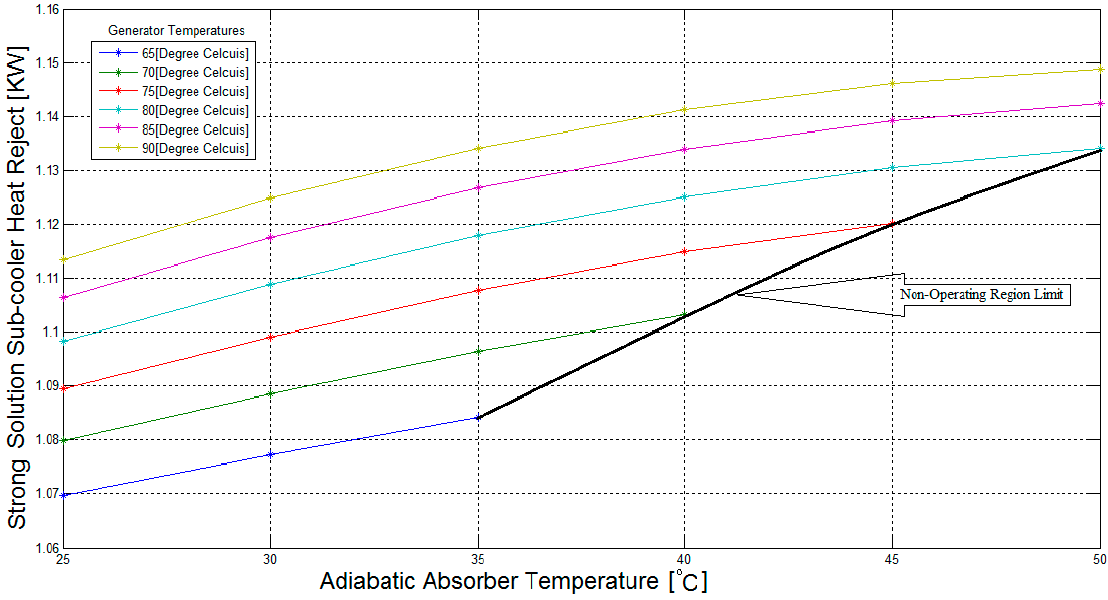
Figure 8. Graph showing the variation of the heat rejection in the strong solution sub-cooler with generator temperature and adiabatic absorber temperature ((cid:1846) (cid:3030)(cid:3042)(cid:3041) = 35 ℃, (cid:1846) (cid:3032)(cid:3049)(cid:3028) = 10 ℃) .